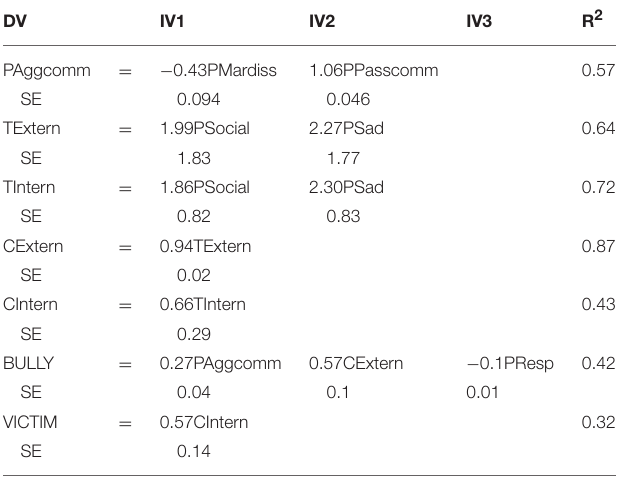
TABLE 5 | Structural equations and their unstandardized regression